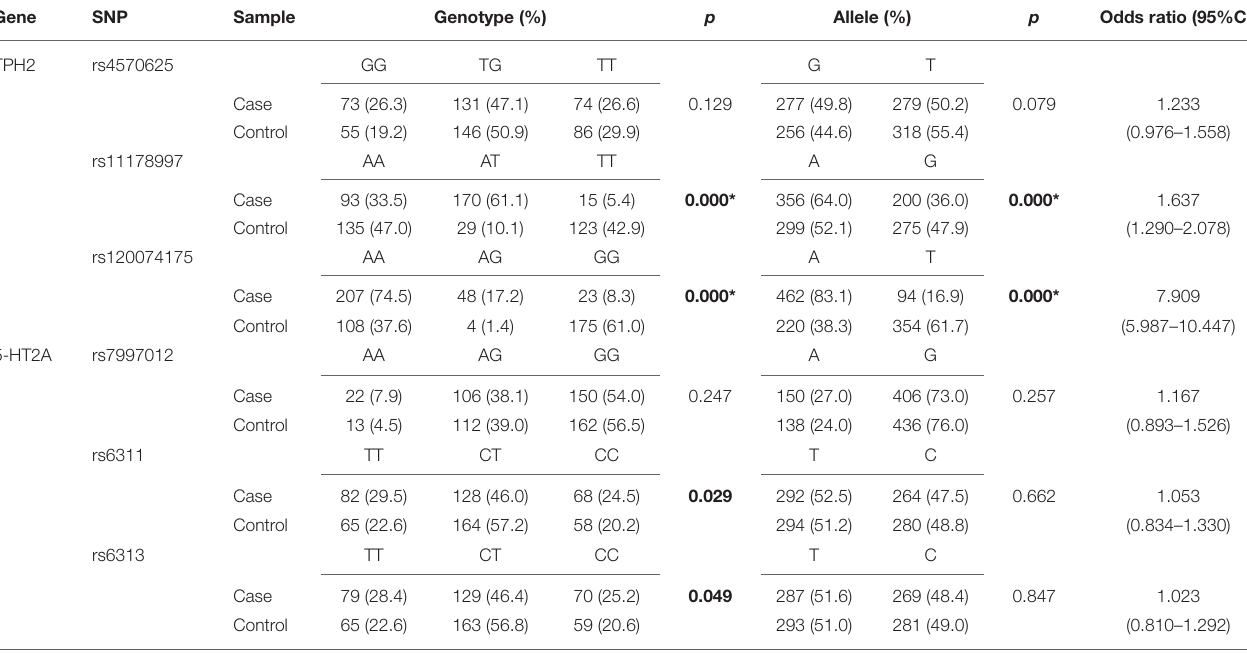
TABLE 3 | Genotypic and allelic distributions of TPH2 and 5-HT2A polymorphisms of MDD patients and controls. Gene SNP Sample Genotype (%) p Allele (%)